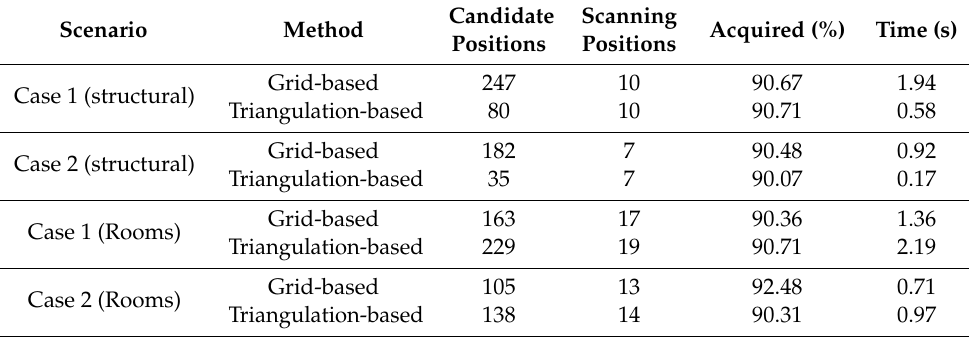
Figure 18. Visibility analysis of case study 1 original ( a ) and rotated ( b ). Visible elements are coloured in green, while black zones correspond to areas of element to be acquired are not visible from any candidate position. Table 6. Results of optimization